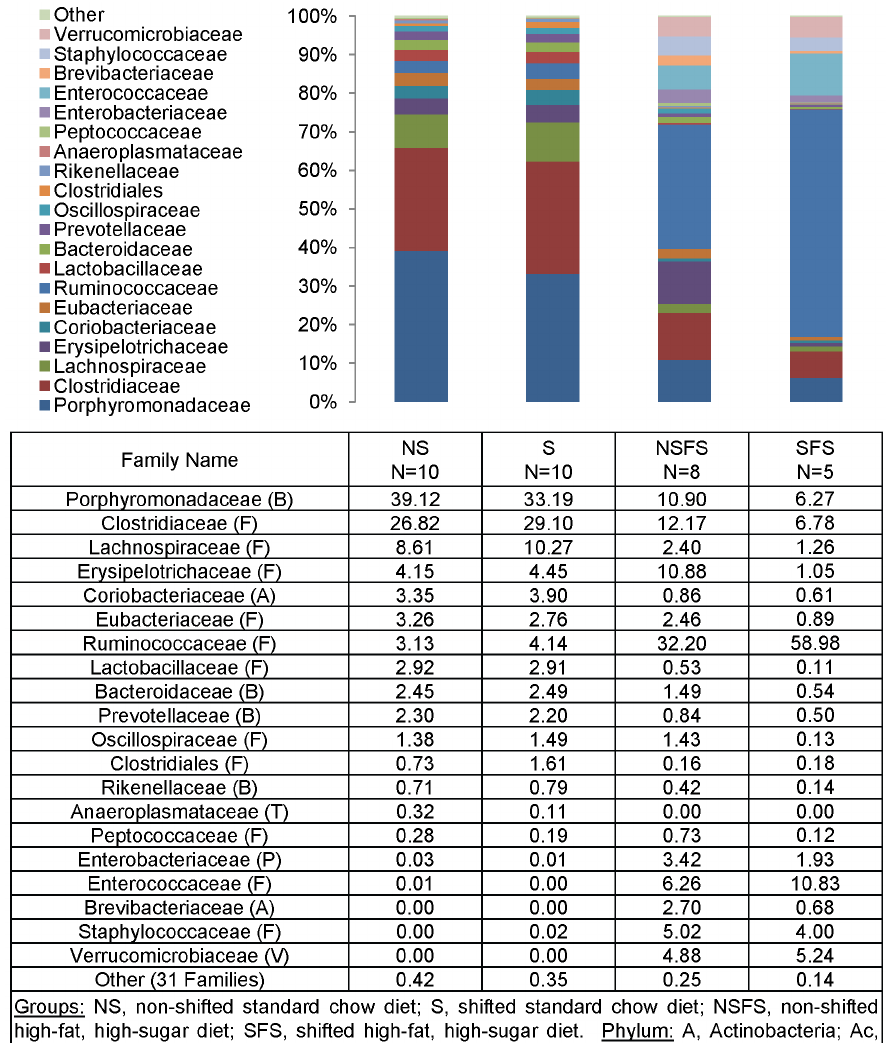
Figure 6. Mouse gut microbial community structure at the family level. The bar graph graphically represents the average relative abundance of classified bacteria SSU rRNA gene amplicons belonging to the most abundant taxon at the family level.